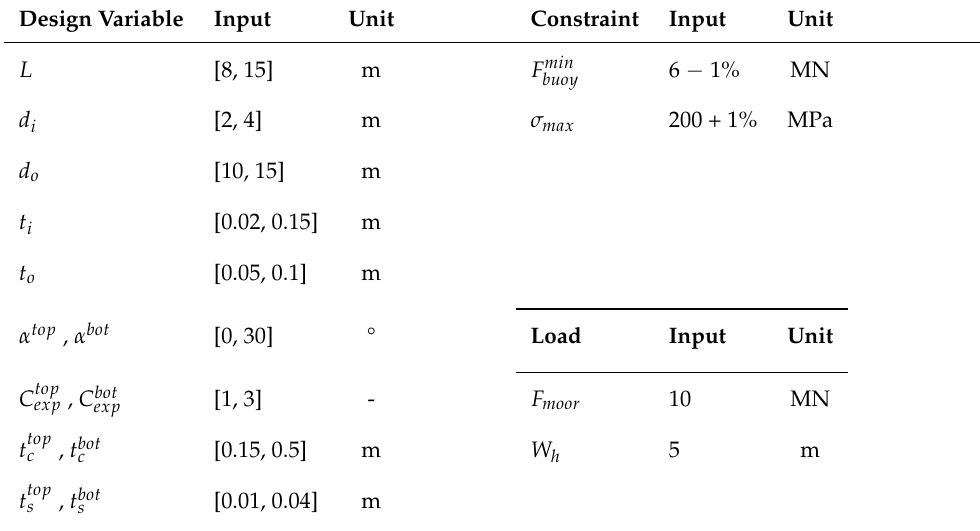
Table 6. Boundaries of the design space, constraints and loads values used as inputs for the given study case.